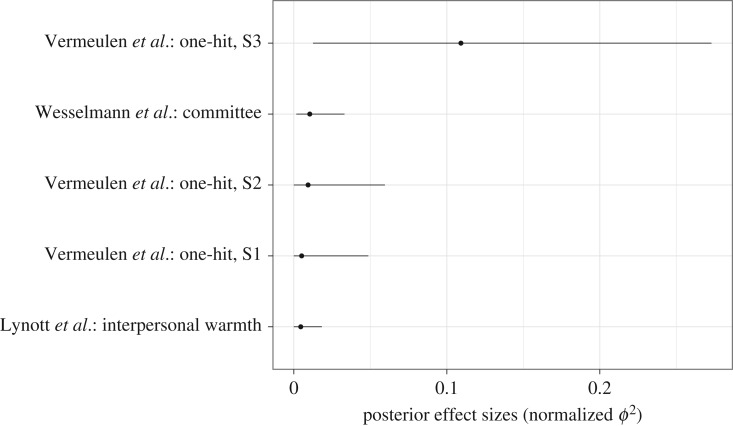
Individual Bayesian parameter estimation results for undirected effect sizes ϕ2 for each of five experiments reported in the Social Psychology special issue using contingency tables. The posterior medians are indicated as dots and the central 95% credible intervals as vertical lines. The effect sizes were estimated using an unrestricted model. Figure available at https://flic.kr/p/EVhMSS, under CC license https://creativecommons.org/licenses/by/2.0/.